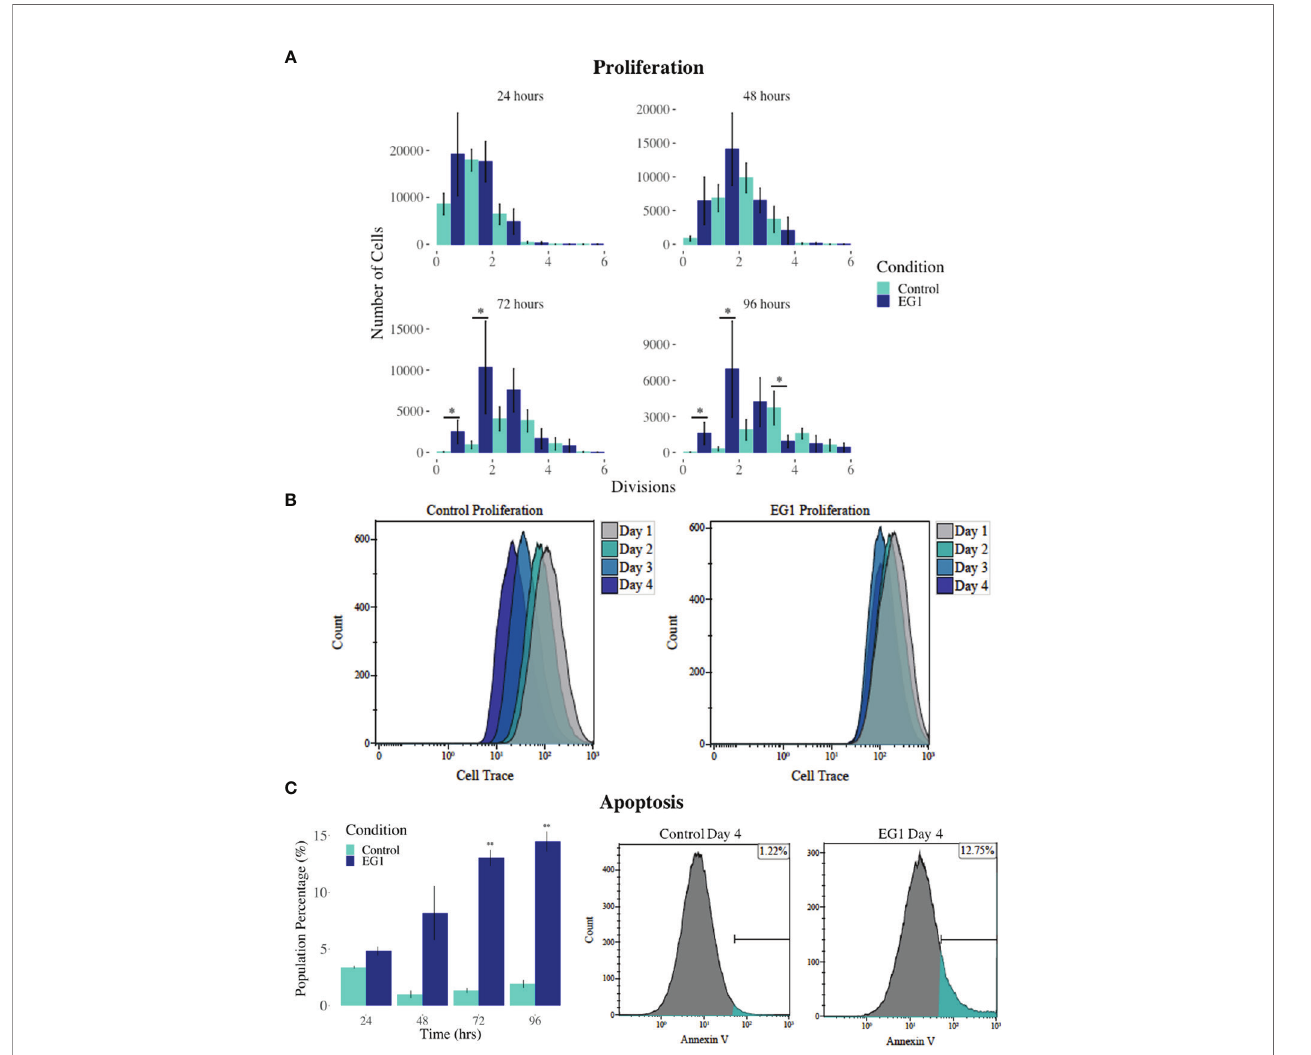
FIGURE 6 | Proliferation and apoptosis in 250 m mol/L EG1 treated and control HCT116 cell cultures. (A) A dye dilution fl ow cytometry assay was performed to determine proliferation in the HCT116 cultures at 24 hours, 48 hours, 72 hours and 96 hours. The population proportion per cellular division was calculated and plotted to show population distributions. At 72 and 96 hours the EG1 treated cultures (dark blue) had undergone signi fi cantly fewer divisions than the controls (light blue) (*p < 0.05, n=3). (B) Flow cytometry data of the dye dilution assay representing the loss of fl uorescence in the controls as they divided and retention of fl uorescence in the EG1 treated cultures as proliferation ceased over 96 hours (n=3). (C) Apoptosis in the control and EG1 treated HCT116 cultures measured via fl ow cytometry showed a signi fi cant increase in apoptosis after 72 and 96 hours. (** p < 0.01,